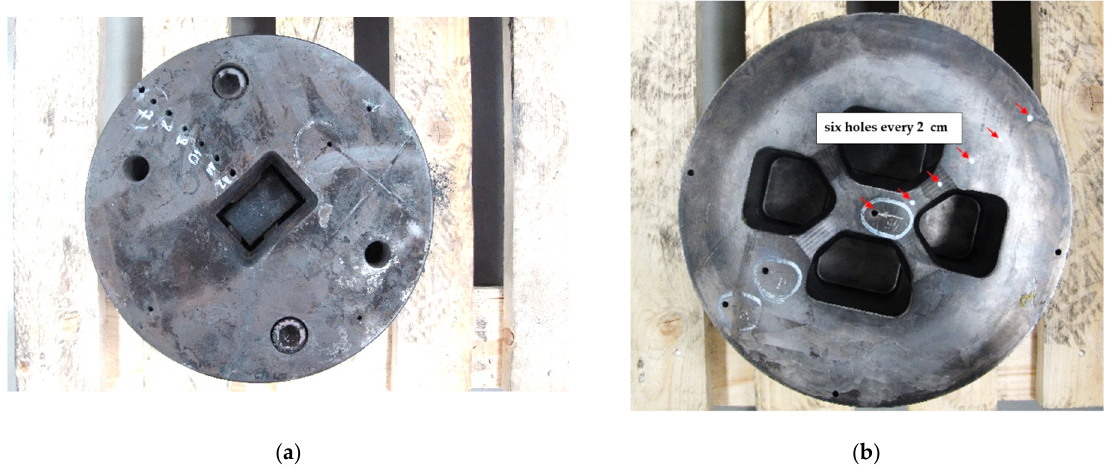
Figure 13. Dies with marked places of thermocouples that measure the achieved temperature during annealing at 460 °C. ( a ) first example of die; ( b ) second exaple of die.